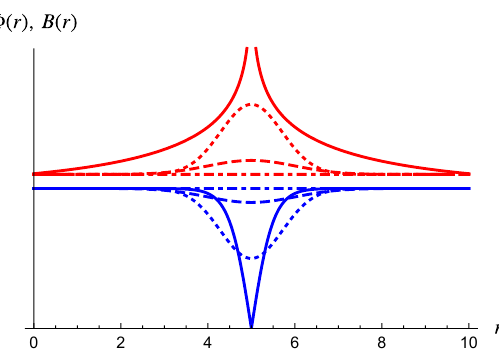
Figure 3 . The field profile evolution when the field strength approaches the superheating field. The magnetic field B (red lines) and the scalar field magnitude | Φ | (blue lines) are both constant in the beginning (dot-dashed). A small perturbation in the magnetic field (dashed) leads to a localized Φ profile. This causes magnetic field to further cluster in the region where h Φ i is small (dotted) and the scalar profile to further develop a dip. The magnetic field grows logarithmically to infinity in this localized region, eventually pushing Φ to zero, creating a vortex. The solid lines show the profiles of a localized vortex as